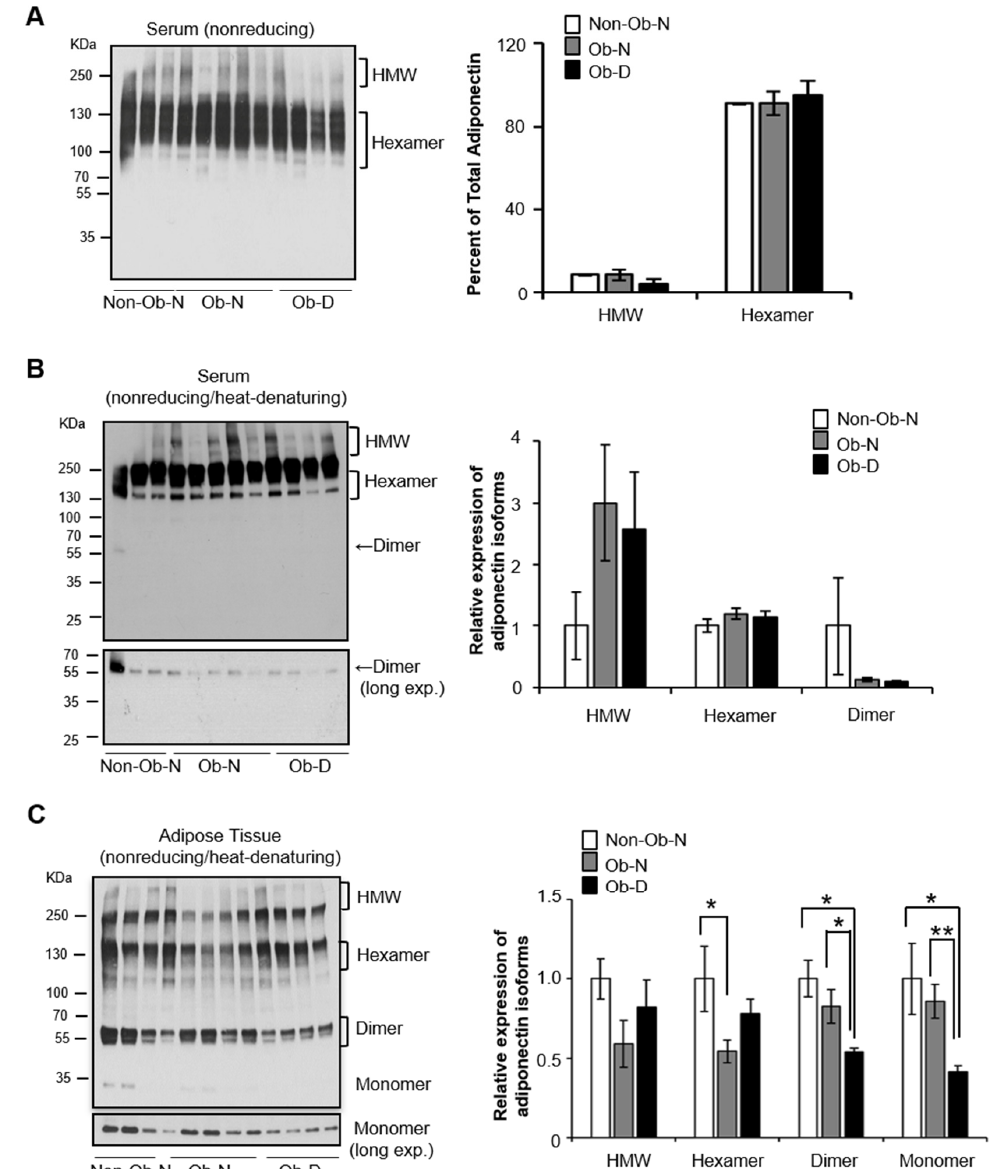
Figure 3. Adiponectin isoform levels. ( A ) Representative image and graphical presentation of adiponectin isomers detected in serum by nonreducing gradient SDS-PAGE and Western blotting. Representative image and graphical presentation of adiponectin isomers detected in ( B ) serum and ( C ) adipose tissue by nonreduced and heat-denatured gradient SDS-PAGE and Western blotting (* p < 0.05 and ** p < 0.01).